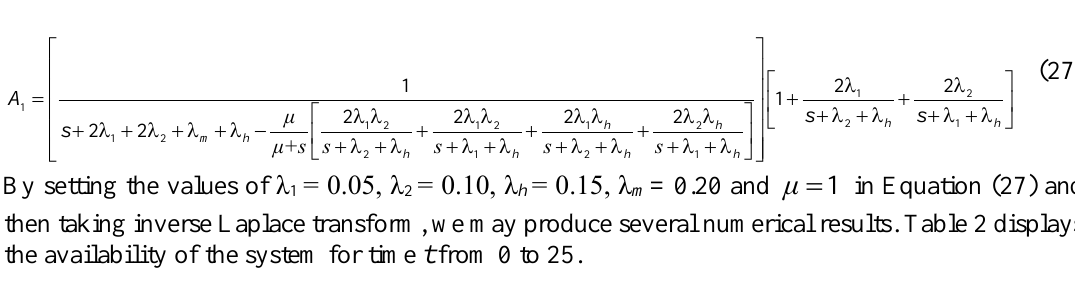
Table 2. Availability of the system without